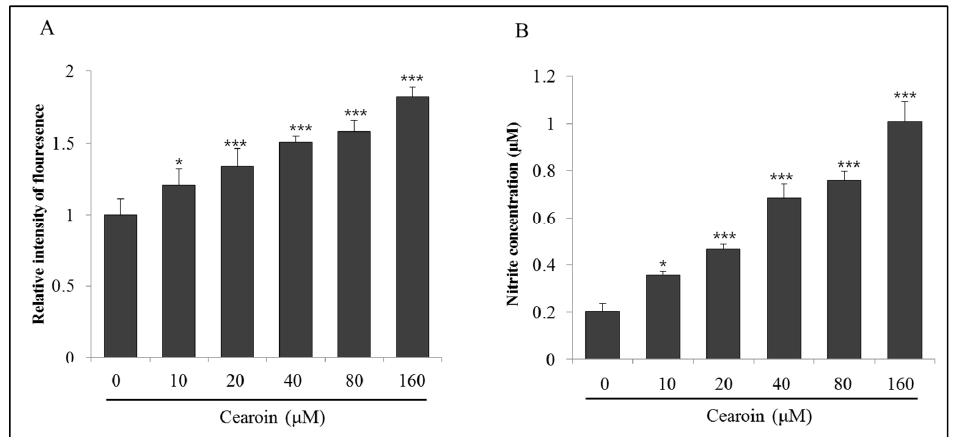
Figure 4. Cearoin increases the intracellular reactive oxygen species (ROS) production and nitric oxide (NO) generation in neuroblastoma SH-SY5Y cells. SH-SY5Y neuroblastoma cells were treated with cearoin in various concentrations (0, 10, 20, 40, 80, or 160 μ M) and incubated for 12 h. ( A ) Intracellular ROS production was measured using DCFDA fluorescence assay. Each bar represents the mean percentage alterations above the control (±SD) ( n = 5); ( B ) total NO release was measured using Griess method. Each bar represents the mean nitrite concentration (±SD) ( n = 6). Differences were considered statistically significant at * p < 0.05 and *** p < 0.001 as compared with the control.